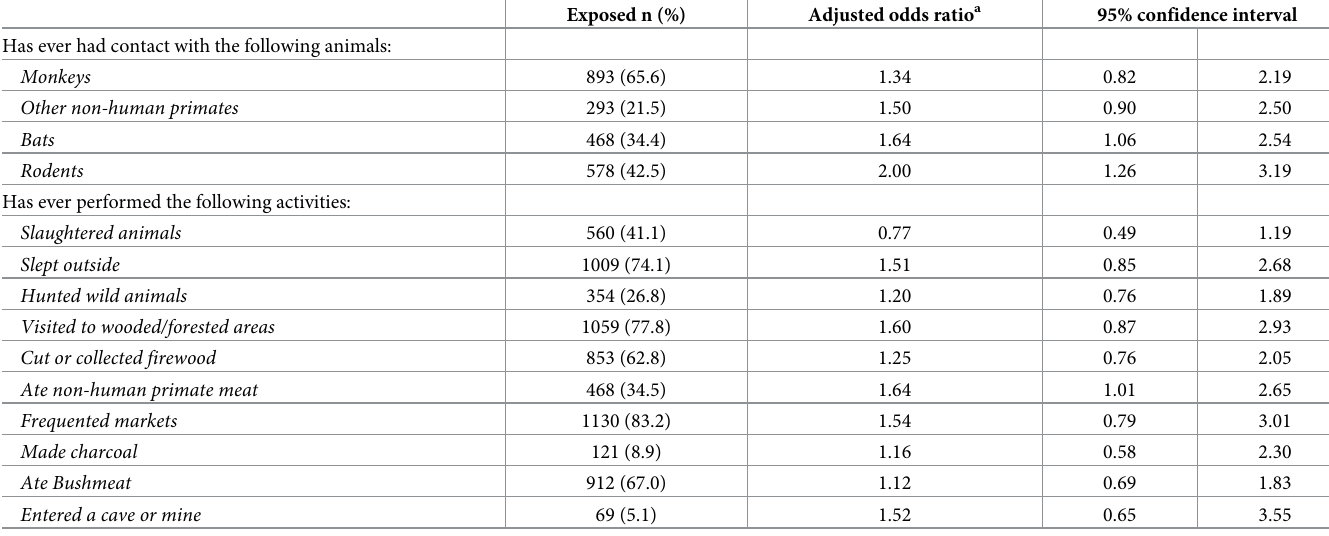
Table 3. Adjusted odds ratios of seroreactivity to Ebola virus GP for various zoonotic exposures among individuals in the Democratic Republic of the Congo, 2015–2017. Exposed n (%) Adjusted odds ratio a 95% confidence interval